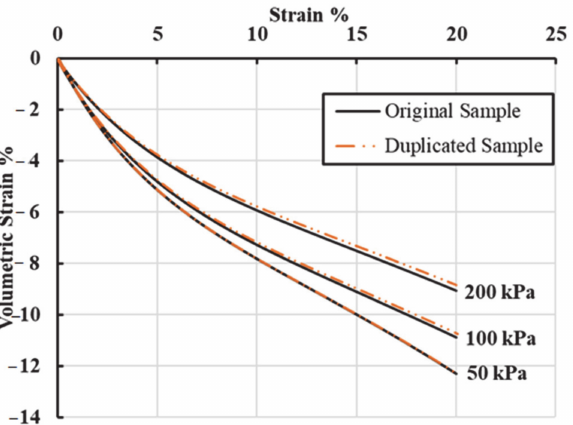
Figure 6. Volumetric strain vs. strain % curves for the duplicated tests for the 25.4 mm sample.